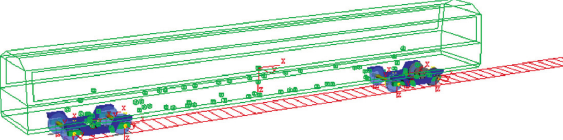
Figure 4: The rigid-flexible coupling dynamics model of the high-speed railway vehicle.